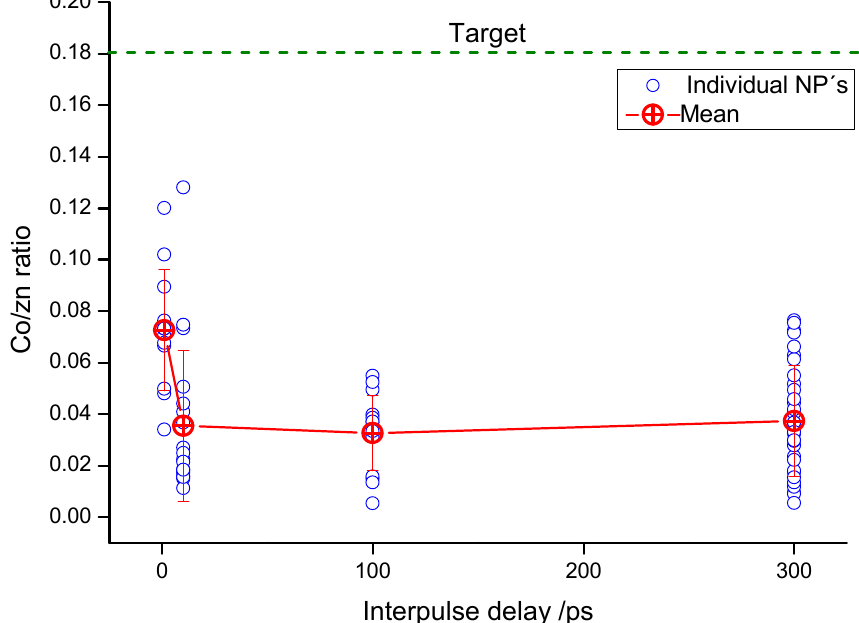
Figure 6. Cobalt to zinc ratios found in individual nanoparticles present in deposits prepared under DP irradiation as a function of the interpulse delay.